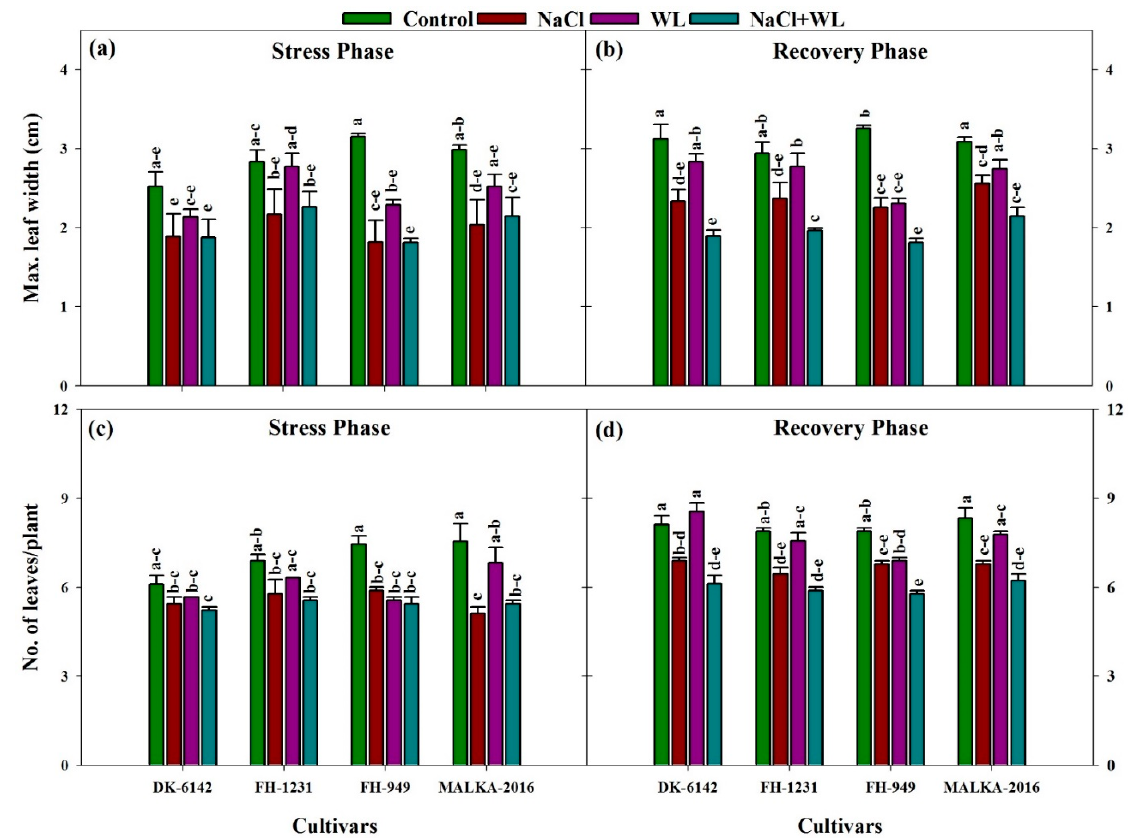
Figure 4. Individual and interactive effects of salinity and waterlogging on maximum leaf width and number of leaves/plant of four maize cultivars during the stress (22 DAS) and recovery (30 DAS) phases. Left and right sides of the figure are representing stress phase and recovery phase respectively. Error bars denote the standard error of three replications. Bars with same letter do not differ significantly at p ≤ 0.05.